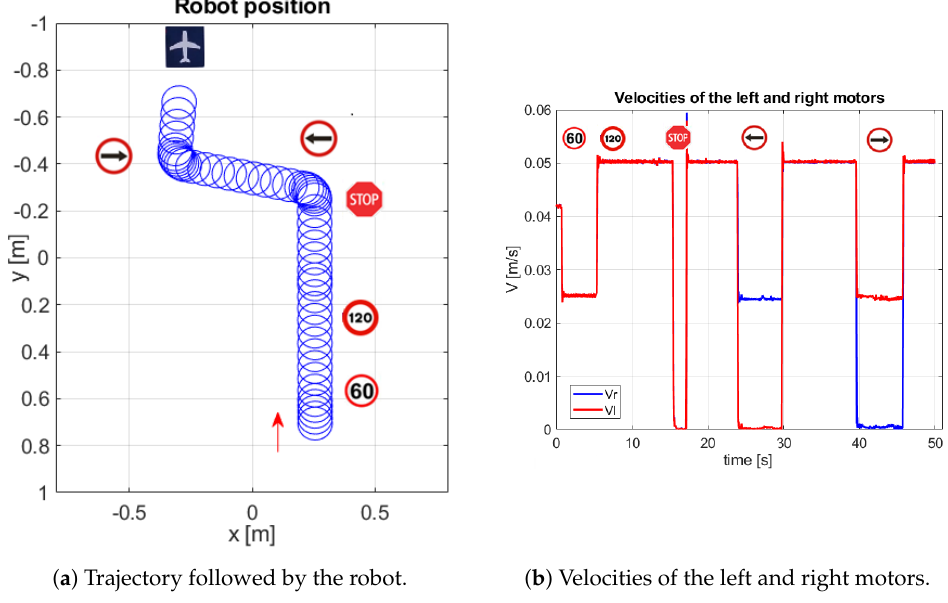
Figure 11. Results of the experiment in simulation environment.